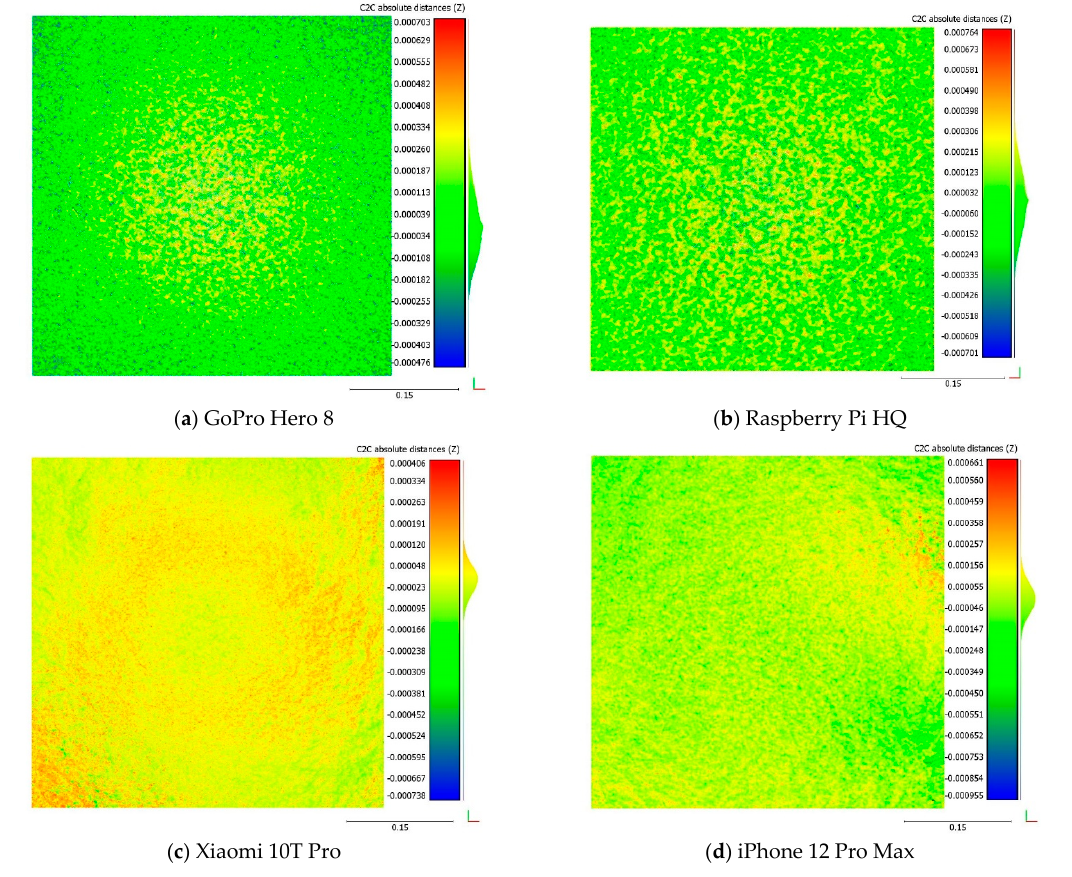
Figure 9. Comparison of cloud ‐ to ‐ cloud distance of low ‐ cost camera point clouds to Canon EOS 5DS R DSLR point clouds of the bottom surfaces. The rasterization grid interval is 0.1 mm.